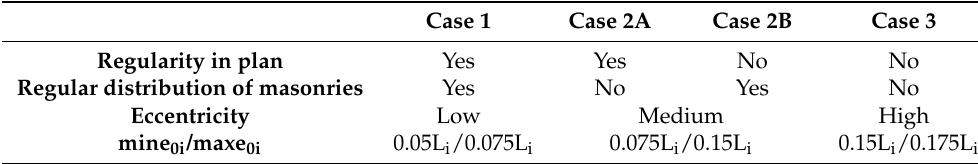
Table 6. Relation assumed between the structural data inserted by the user and the structural eccentricity e